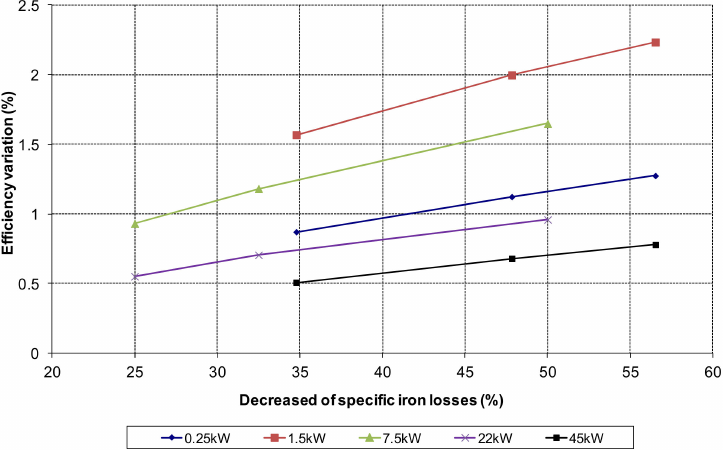
Figure 11. Efficiency variation versus decreased of specific iron losses in all the motors (equal heating criteria).